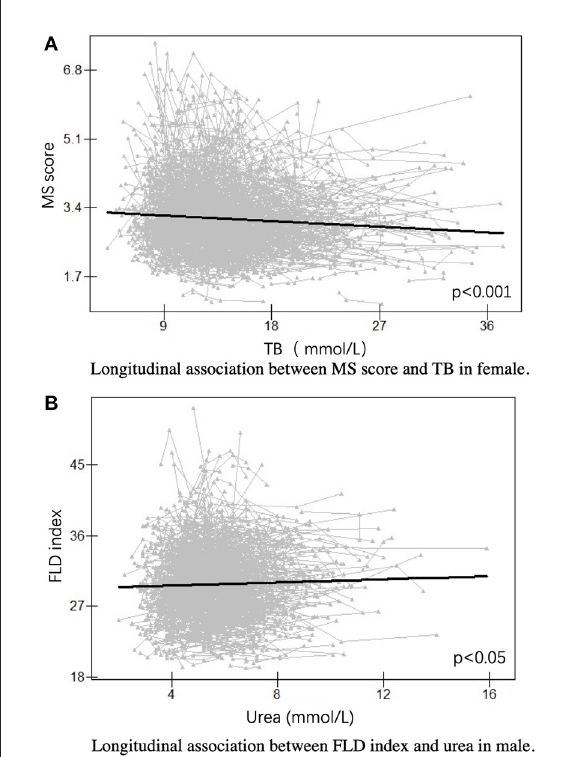
FIGURE4 Longitudinal association in females and males. (A) Longitudinal association between MS score and TB in female. (B) Longitudinal association between FLD index and urea in male. FLD index, fatty liver disease index; MS score, metabolic syndrome score; TB, total